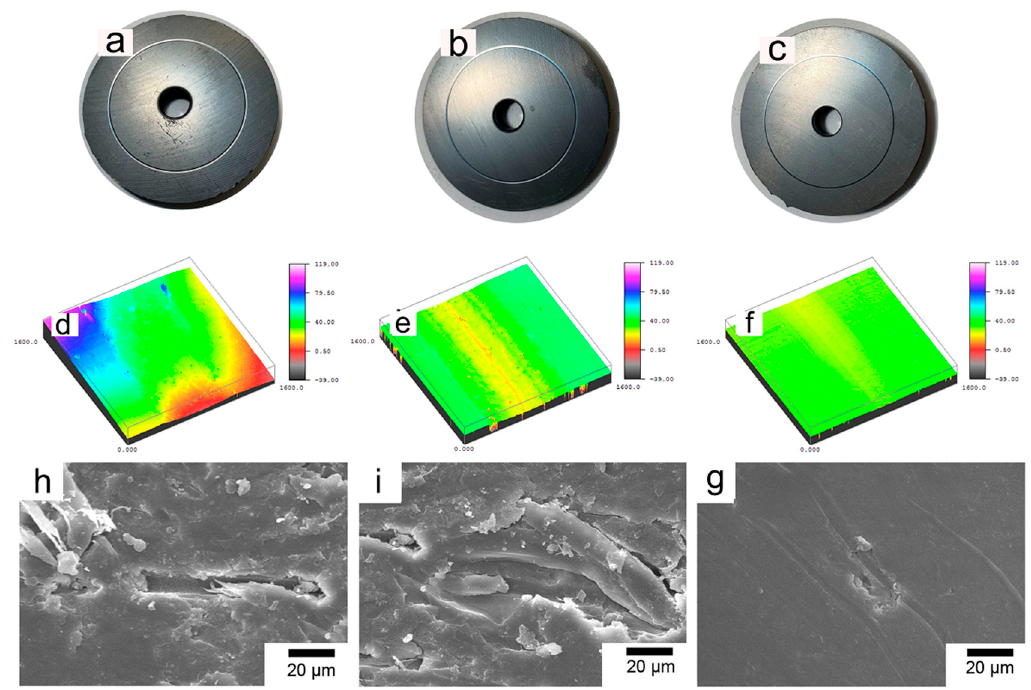
Figure 13. The appearance and SEM photographs of the wear scars of the ( a , d , h ) PBO-Pre / PI, ( b , e , i ) PBO-APTES / PI, and ( c , f , g ) PBO-La / PI composites.